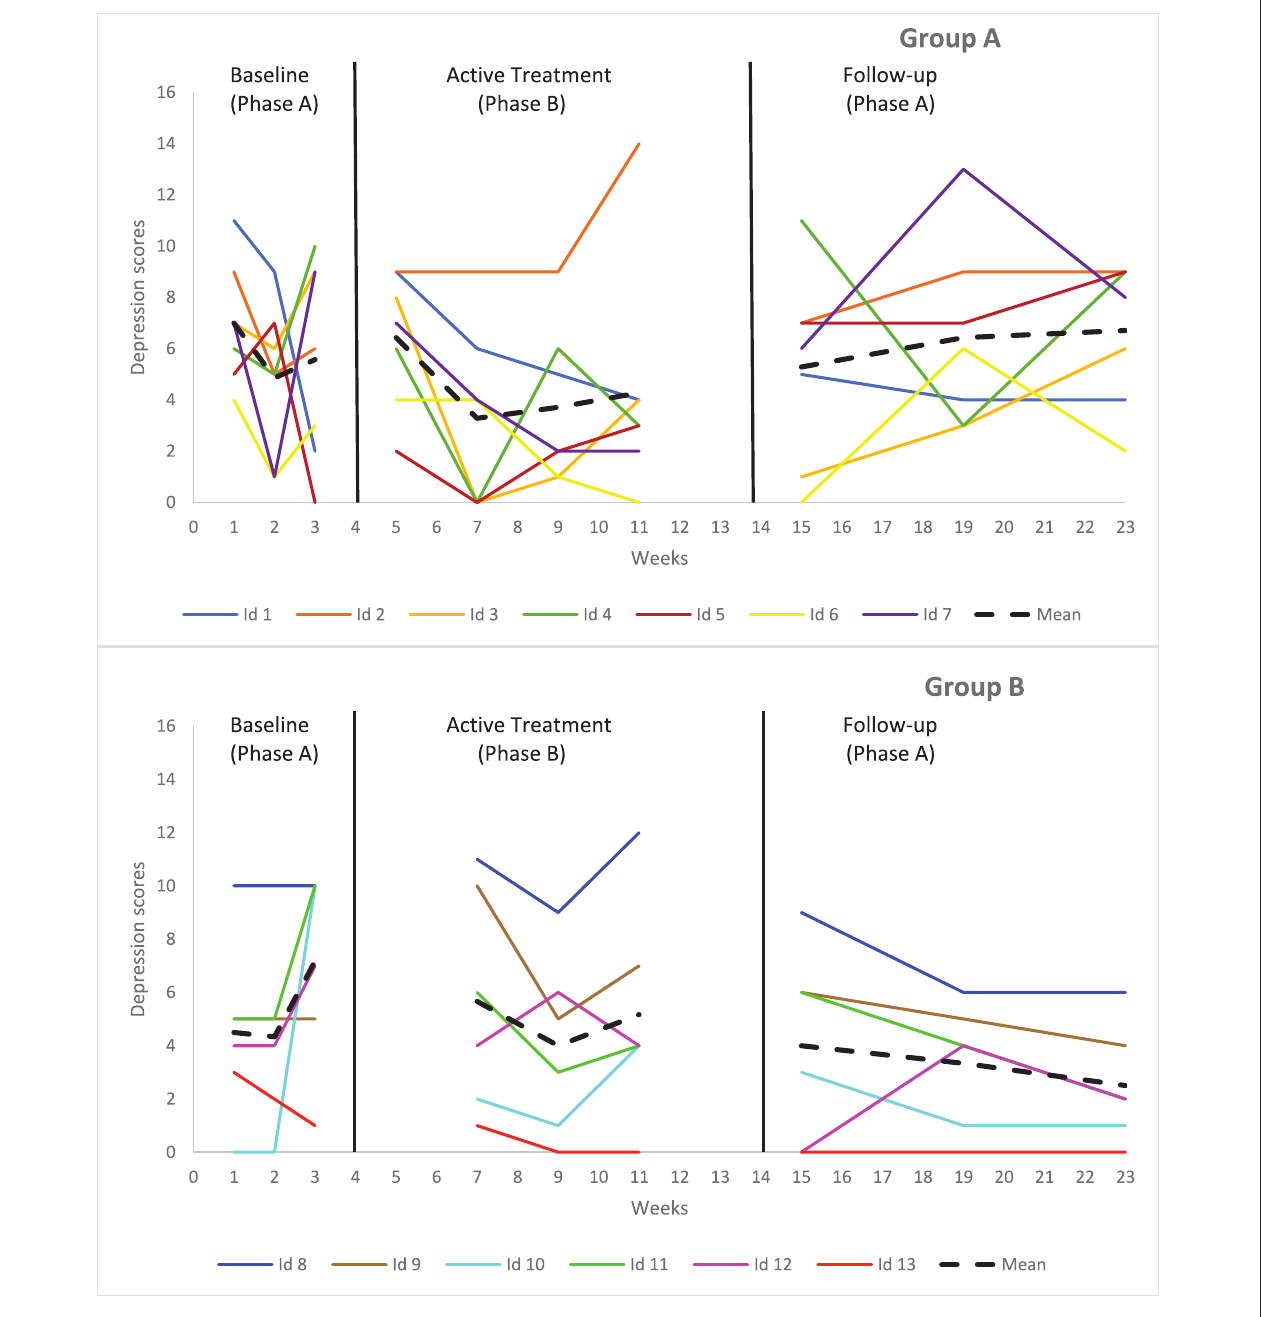
FIGURE 8 | Graphical display of baseline level and changes in level between consecutive phases in depression for teacher-reported